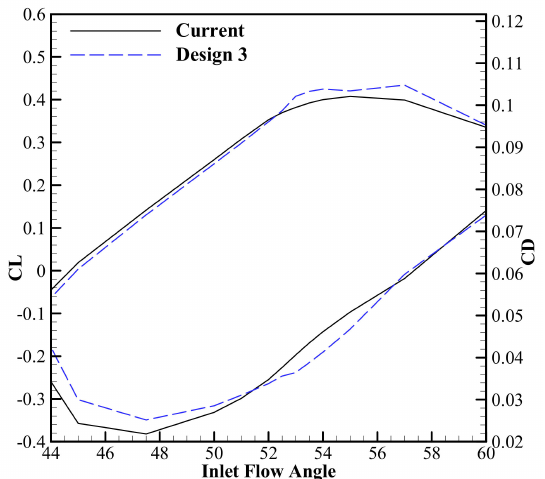
Figure 32. Variation of lift and drag coefficients versus inlet flow angle for the current and the third designed blade